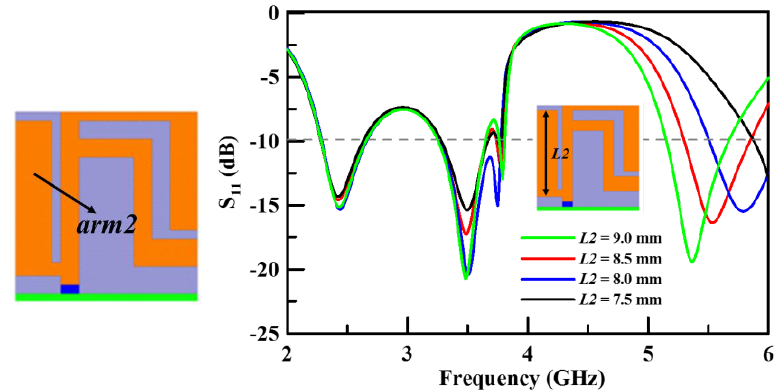
Figure 6. The simulated return loss with various lengths of L2 (Step 3).